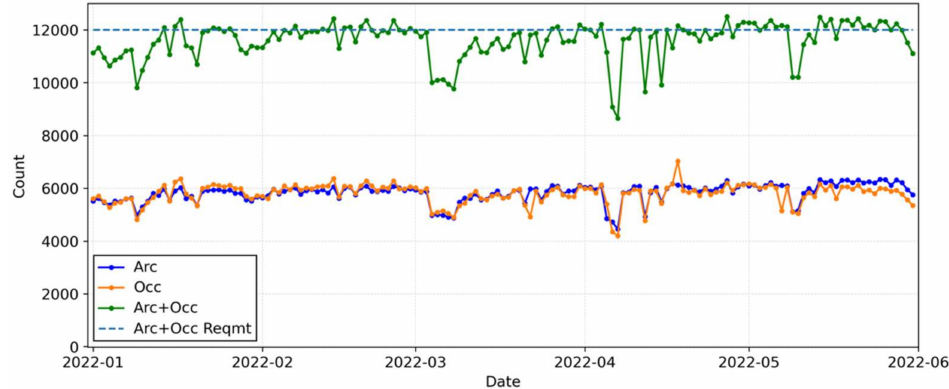
Figure 4. TGRS TEC arc, occ, and arc plus occ scores in 2022.